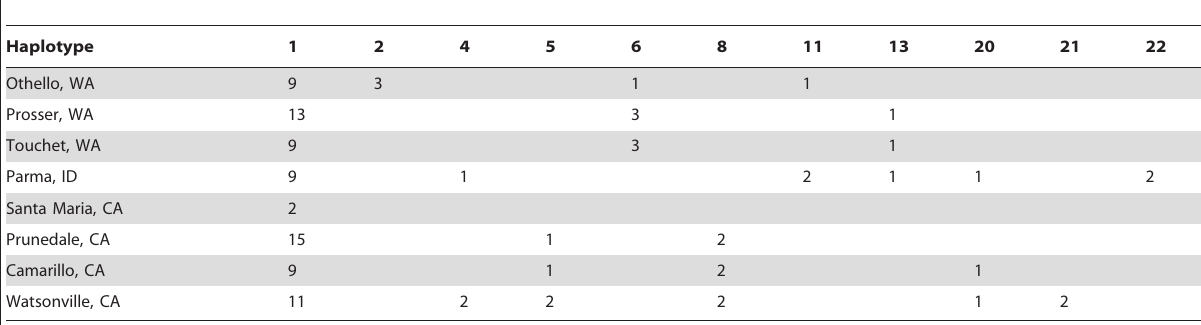
Table 4. Geographic distribution of haplotypes with more than one individual.